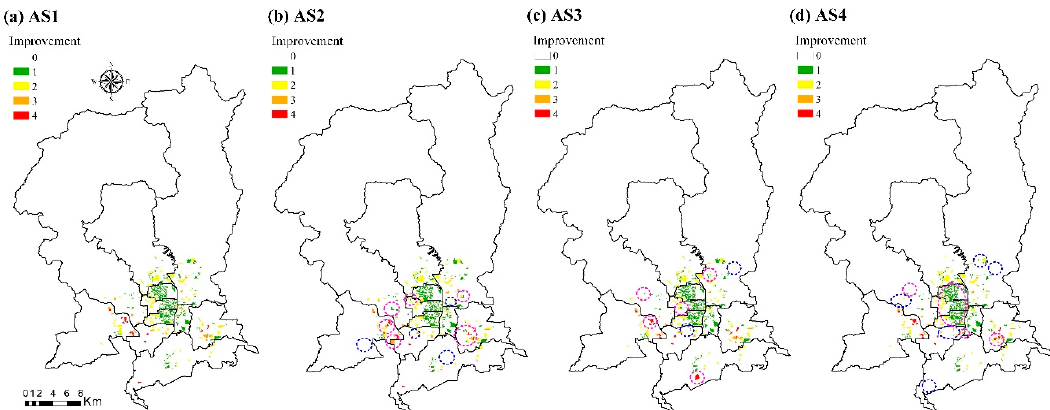
Figure 12. Decreased levels of climate risk in each section of village with the potential climate adaptation strategies for 2025. Note: Same as the note in Figure 10. The blue dotted circles for AS2, AS3 and AS4 indicate that the improvement decreases compared to AS1; the pink dotted circles for AS2, AS3 and AS4 indicate that the improvement increases compared to AS1.